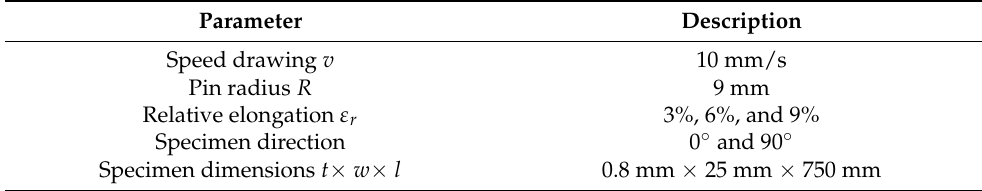
Table 4. Operating parameters used in the formability